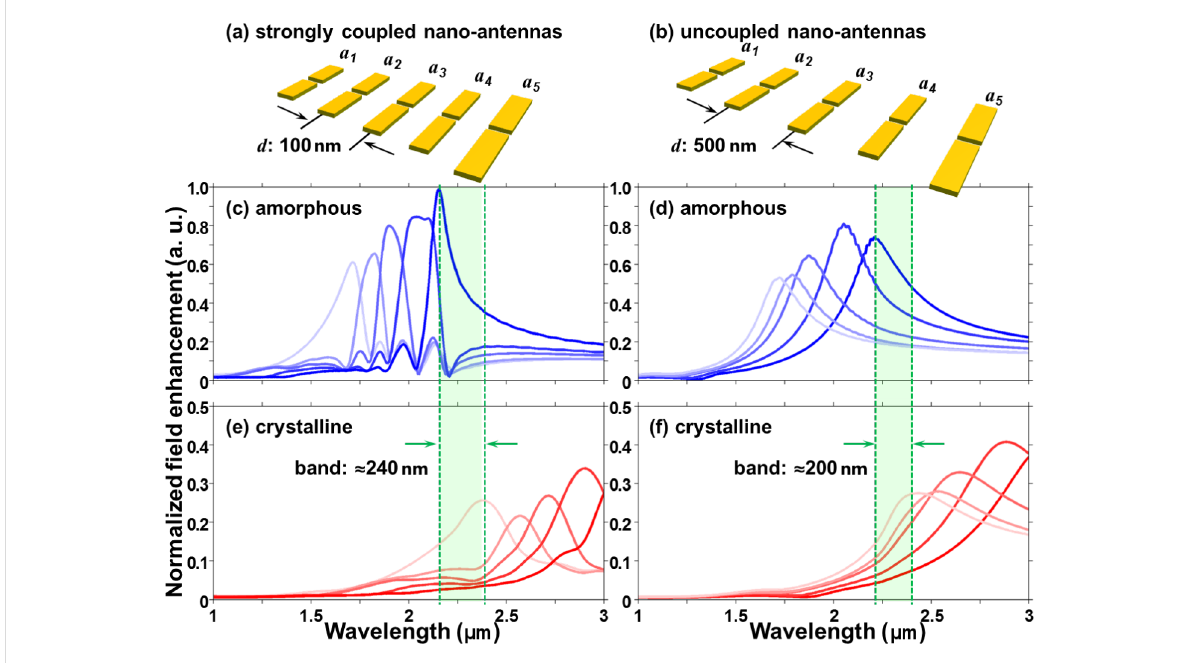
Figure 4: Comparisons between the strong plasmon coupling and uncoupled nano-antennas system. The antennas in the two arrays have the same geometric parameters but different centre-to-centre spacing d . Simulation results, (c) and (d), show a good excitation selectivity in the strong plasmon coupled nano-antenna array due to the sharp spectral features. By controlling the crystalline proportions of an underlying GST thin film, the reson- ance peaks of each antenna may cross a selected illumination wavelength, indicating that the antennas are individually excited. Also, a broader range of choosing feasible illumination wavelengths as the green band shows in (e) and (f) can be obtained in the strong plasmon coupling system by switching the GST completely from the amorphous state to the crystalline